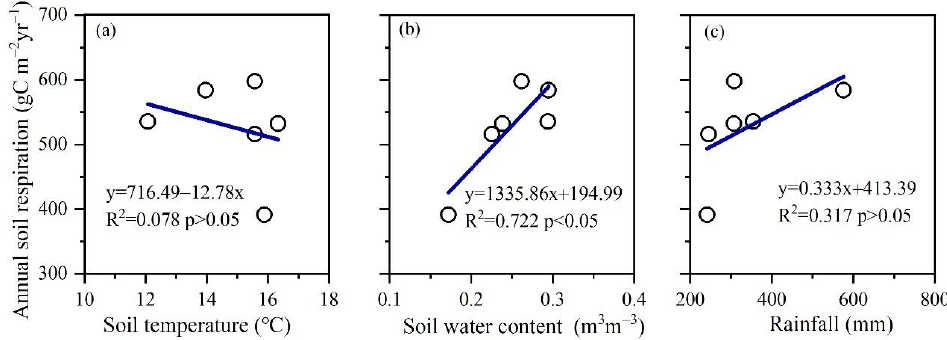
Figure 5. Relationships between annual measures of soil respiration and soil temperature ( a ), soil water content ( b ) at 10 cm depth, and rainfall ( c ) during growing seasons.